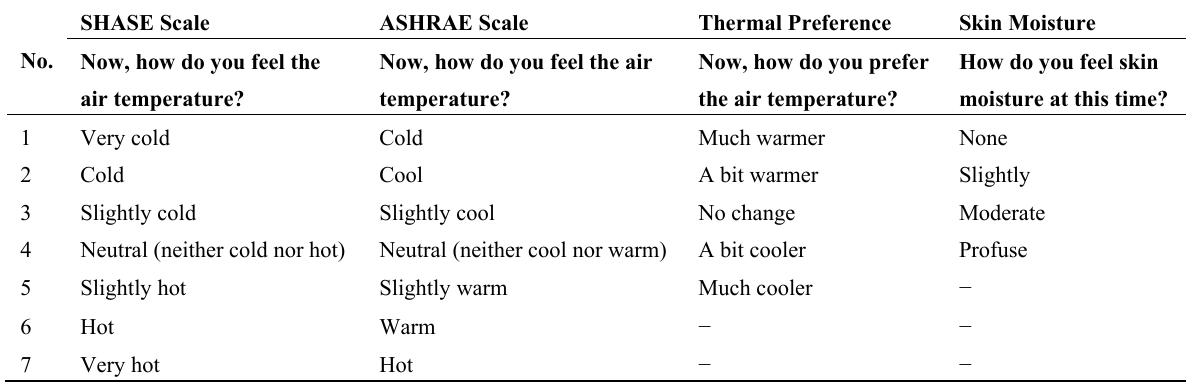
Table 3. Questionnaires for thermal comfort